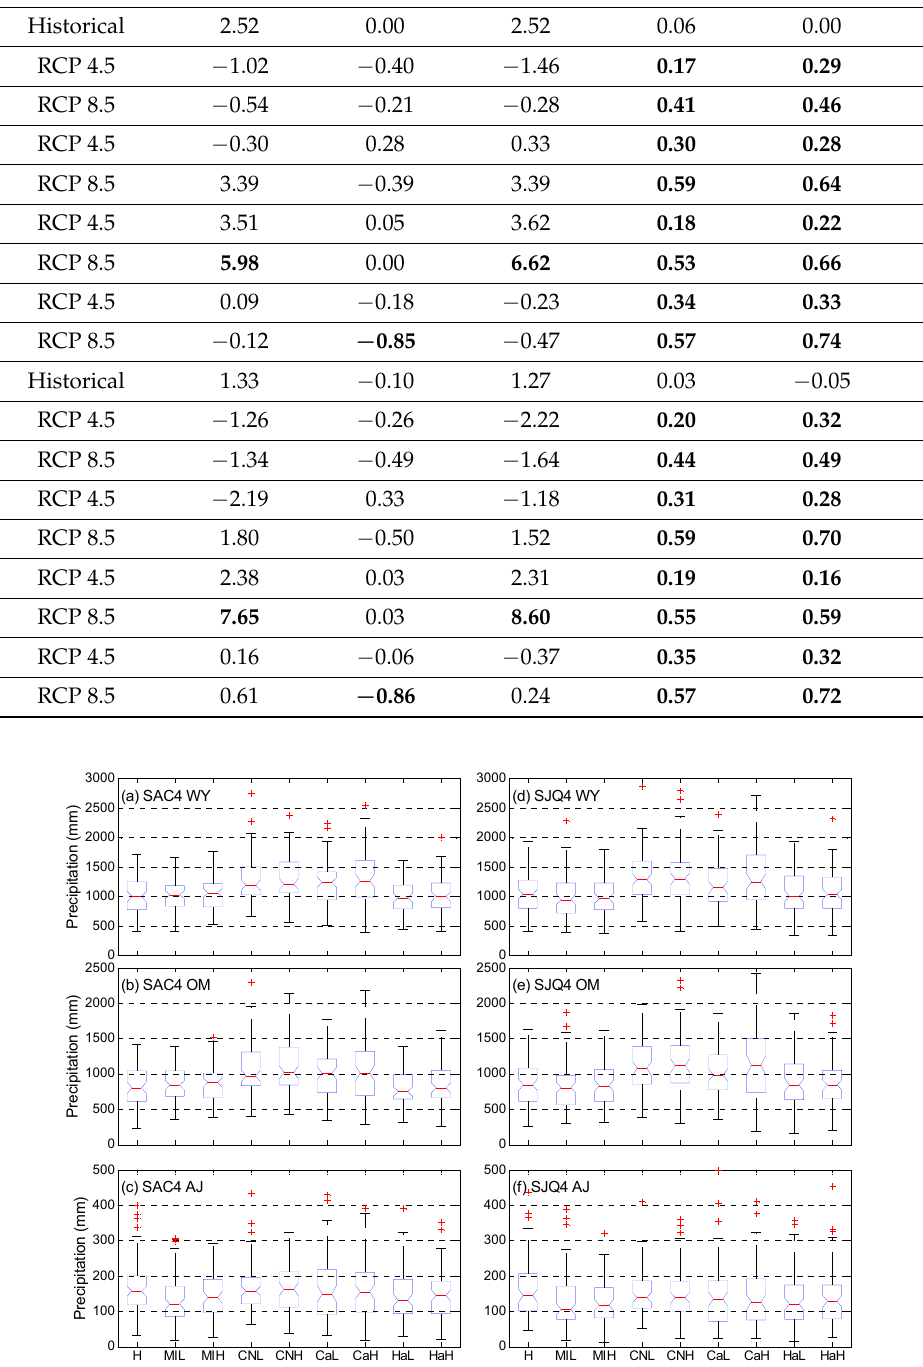
Table A4. Slopes of trends in precipitation and temperature (bold number indicates that trend is statistically significant).